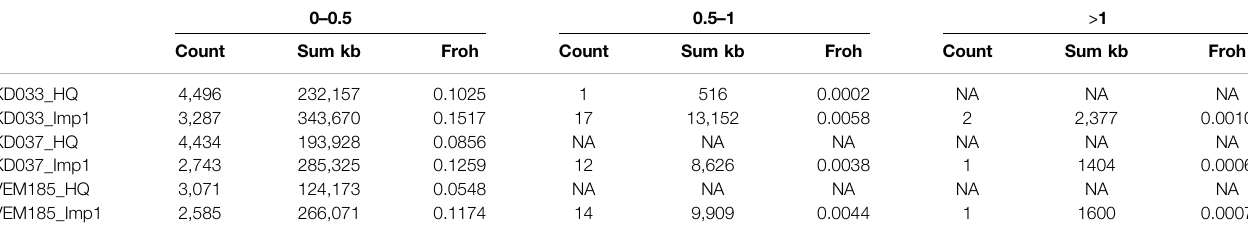
TABLE 4 | ROH statistics of the IMP1 reference panel for all autosomes shown per class of 0 – 0.5 mb, 0.5 – 1 mb, and > 1 mb. 0 – 0.5